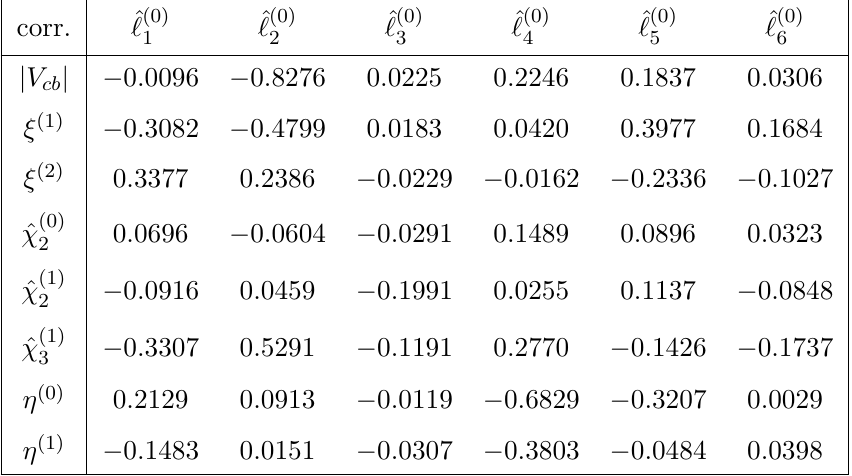
n (cid:24) ( n ) ; ^ (cid:31) ( n )